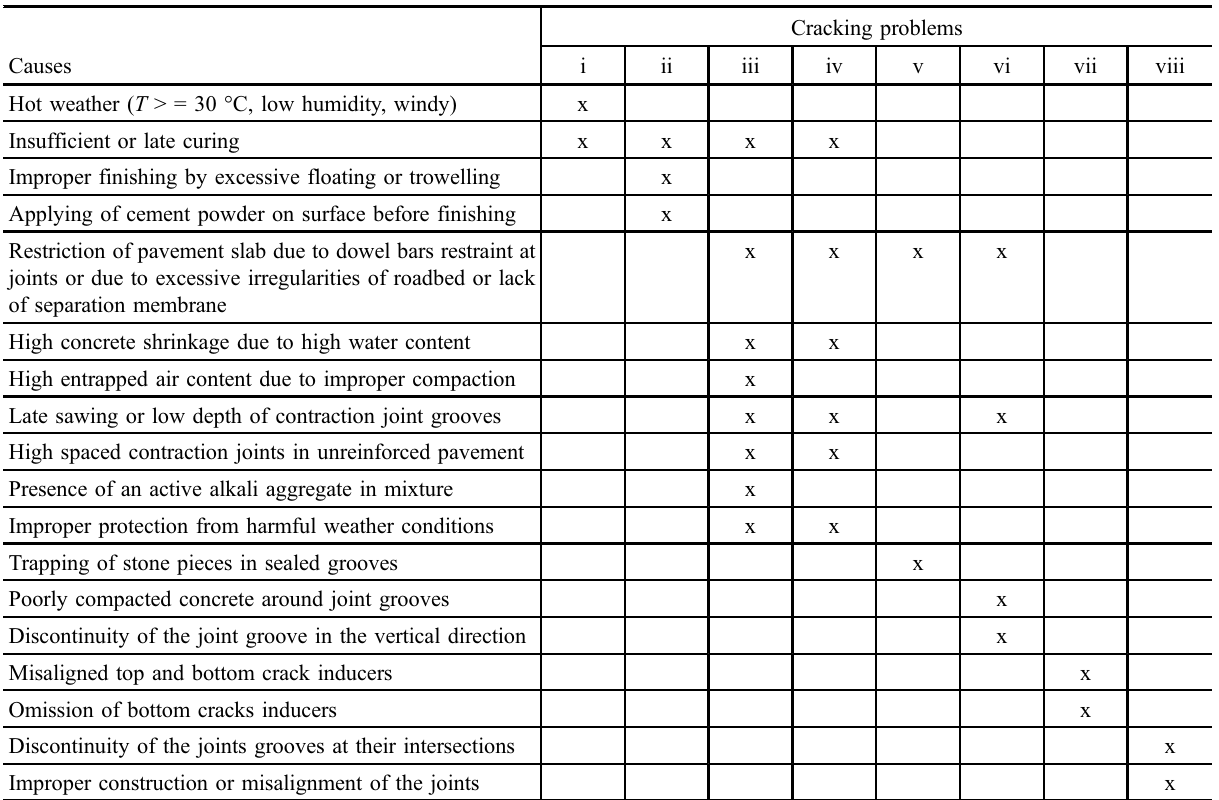
Table 1. Causes of cracking